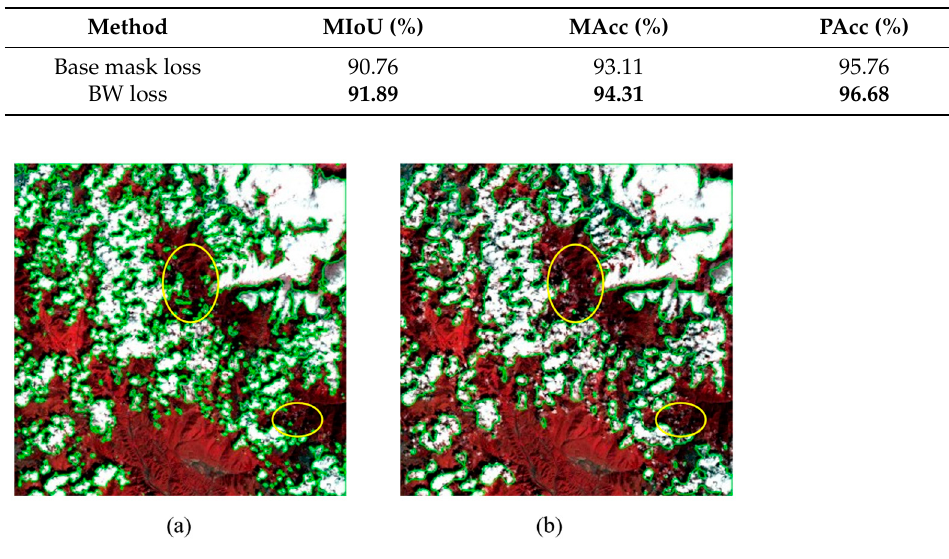
Figure 6. Comparison of visualization results. ( a ) BW loss ( b ) Base mask loss.